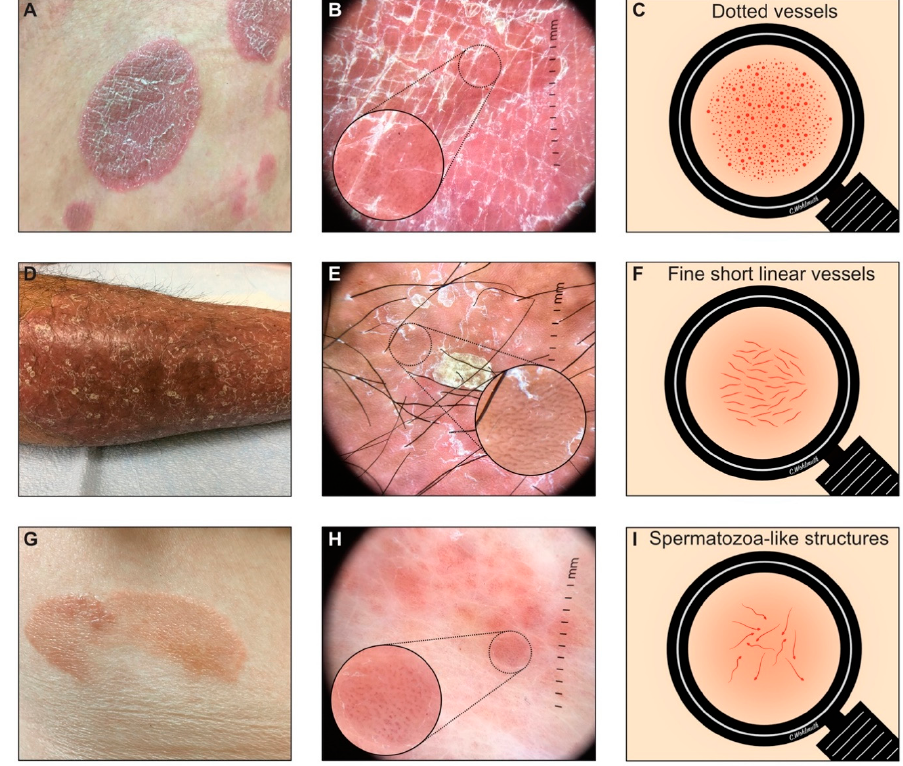
Figure 1. ( A – I ): Vascular patterns. Dermoscopic features of vascular patterns. ( A – C ): clinical, dermoscopy and schematic image of dotted vessels. ( D – F ): clinical, dermoscopy and schematic image of fine short linear vessels. ( G – I ): clinical, dermoscopy and schematic image of spermatozoa-like structures.